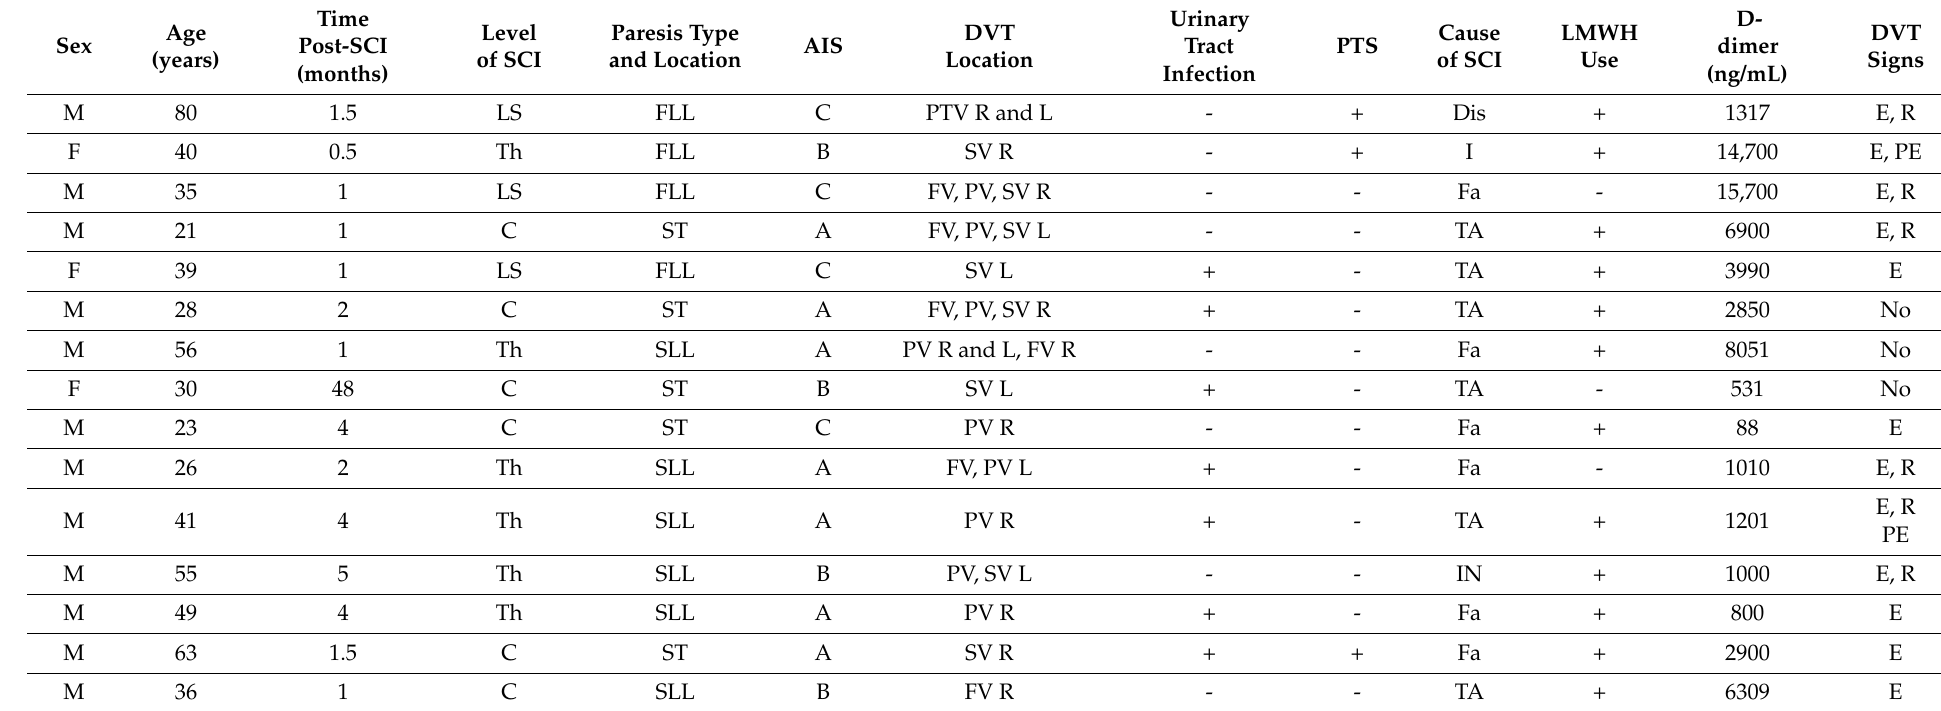
Table 2. Clinical characteristics of specific patients with deep vein